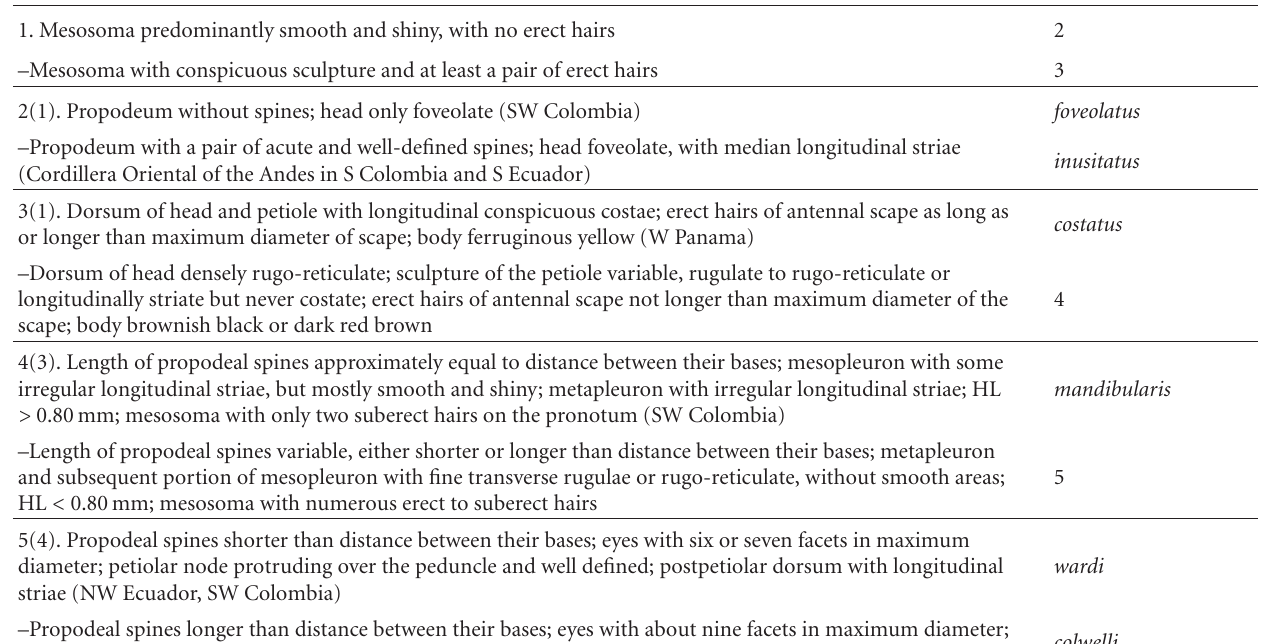
Table 1: Key to the workers of the six described Lenomyrmex species.